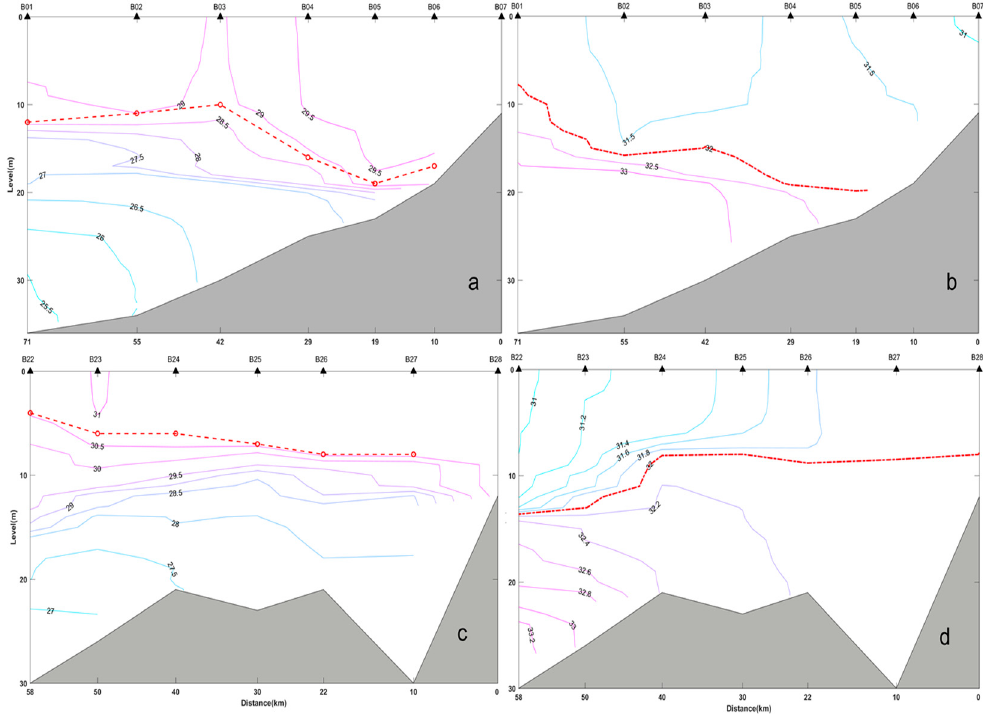
Figure 4. Vertical distributions of temperature and salinity in section L1 ( a , b ) and section L4 ( c , d ), respectively, during investigation period in May 2021. The red dashed line is the thermocline depth ( a , c ); the red dotted line is the salinity 32 isoline ( b , d ).